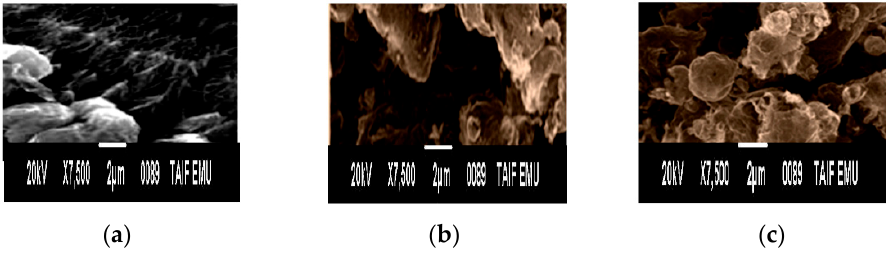
Figure 7. RGOSEM image sat ( a ) room temperature, ( b ) 300 °C, and ( c ) 500 °C.